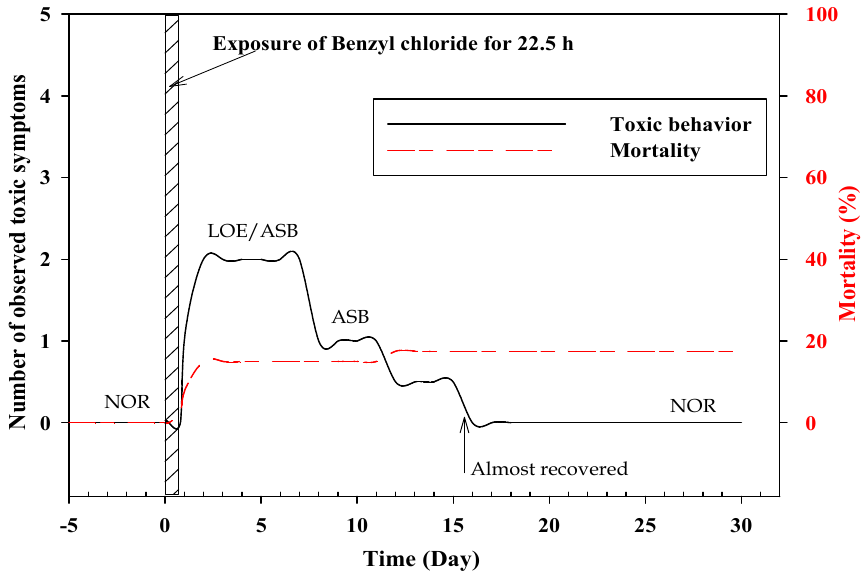
Figure 3. Survival rate and toxic behaviors of Z. platypus in the 4 µL/L benzyl chloride. (LOE: loss of equilibrium, ASB: abnormal swimming behavior, NOR: normal). Table 6. Survival rates and condition factors in Z. platypus and A. chinensis, following benzyl chloride